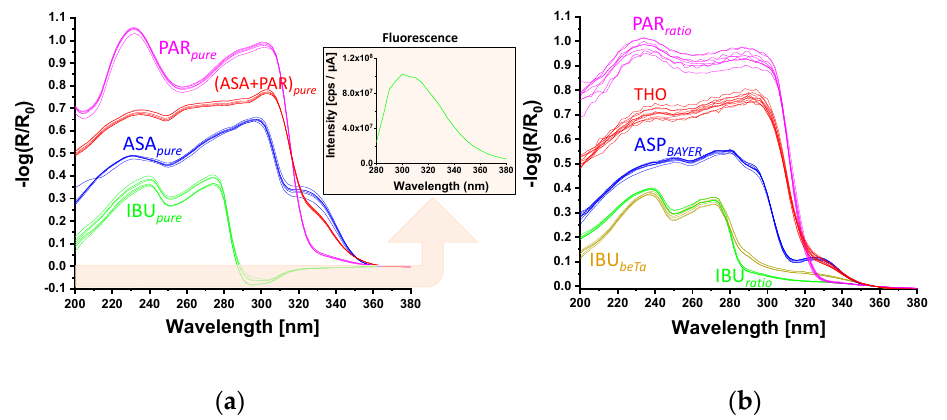
Figure 5. UV total hemispherical reflectance spectra of drug samples in the solid phase in the wavelength range 200–380 nm. ( a ) API drugs IBU pure , ASA pure , PAR pure and a mixture of ASA pure with PAR pure . Upper right: Fluorescence emission of IBU sample with excitation at 270 nm. ( b ) Painkiller tablets IBU ratio , IBU beTa , ASP ratio , PAR ratio and THO.